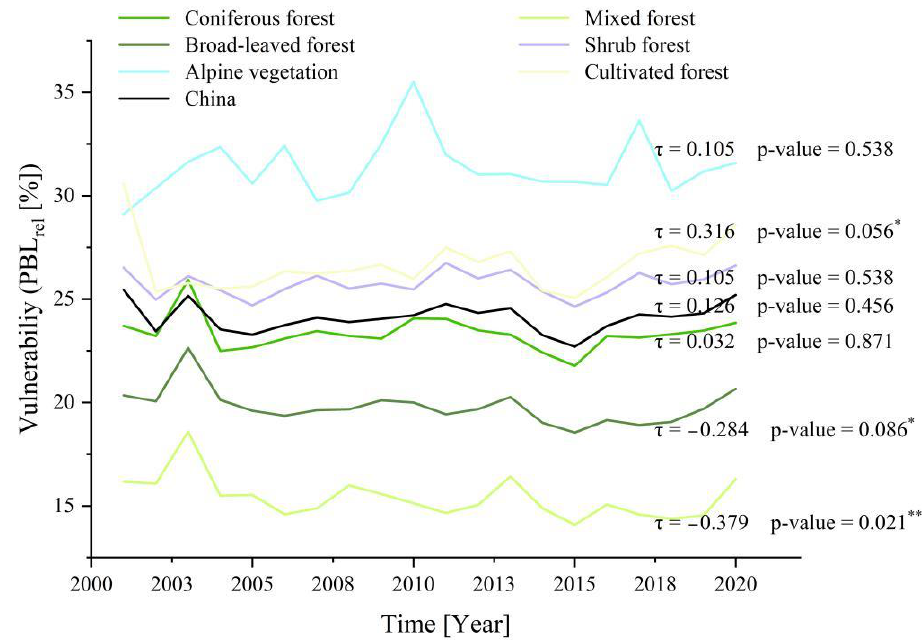
Figure 7. The time series of forest vulnerability to fire disturbance (PBL rel ) of the main forest types from 2001 to 2020 (* and ** indicate p < 0.1 and p < 0.05, respectively).